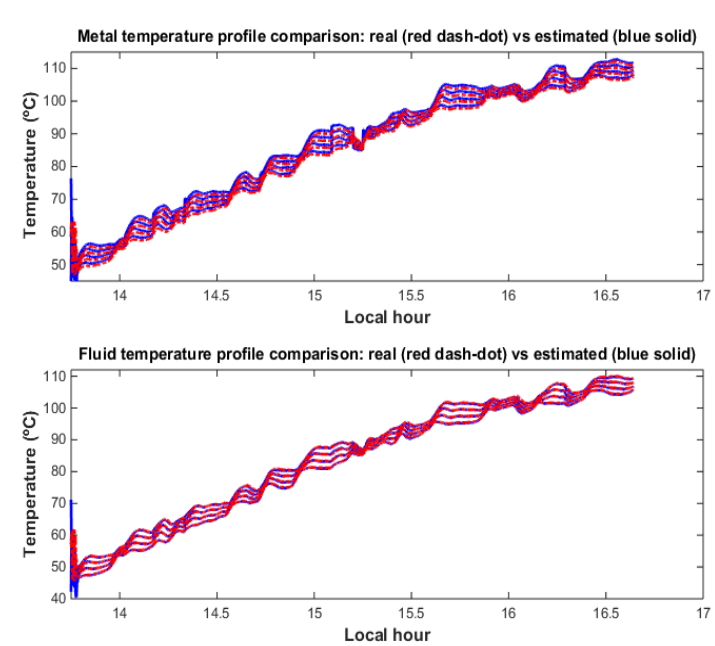
Figure 16. Simulation 2: Temperature profiles estimation. Estimated (solid blue line) and Distributed parameter model (dash red